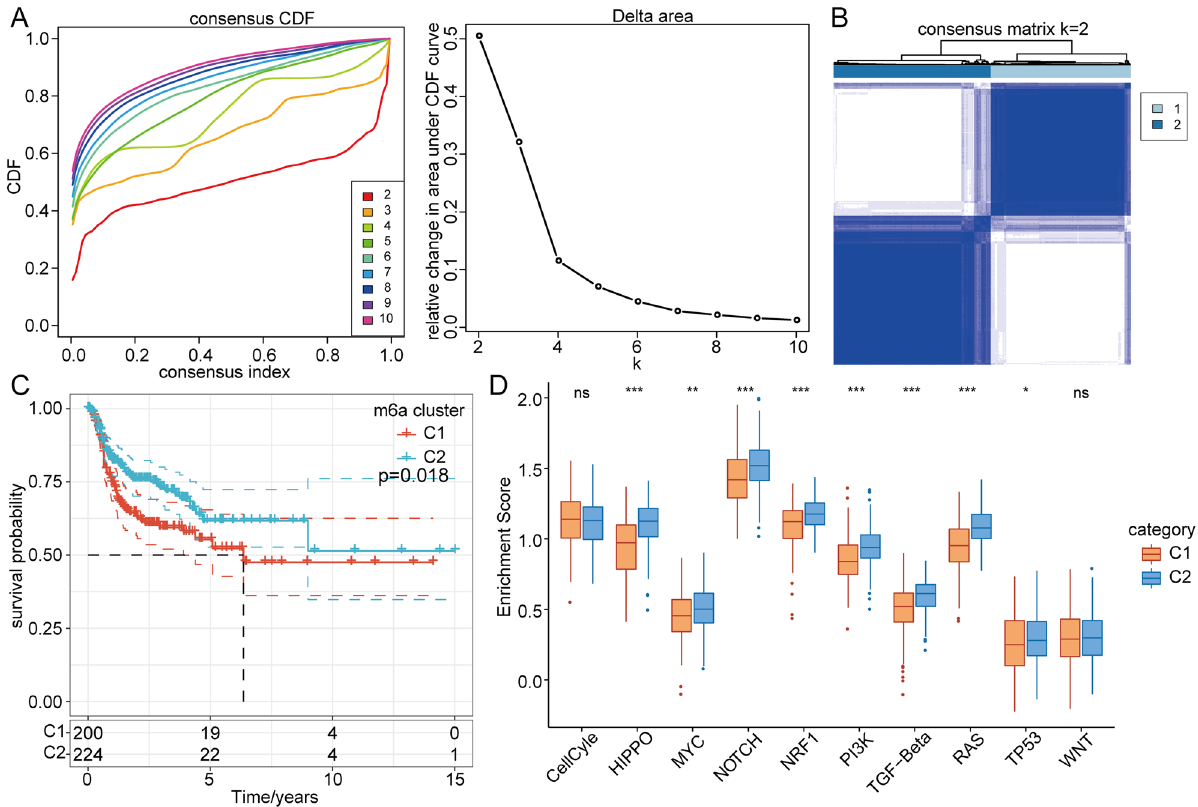
Figure 2. Construction of m6A-related subtypes. ( A ) CDF curve and CDF curve delta area of the TCGA HNSCC cohort. ( B ) T Sample clustering heatmap, consensus K = 2. ( C ) KM curve of the two subtypes in the TCGA-HNSCC cohort. ( D ) Estimation of the scores of different subtypes in 10 abnormal tumor pathways. ( E ) Proportions of immune cells in different